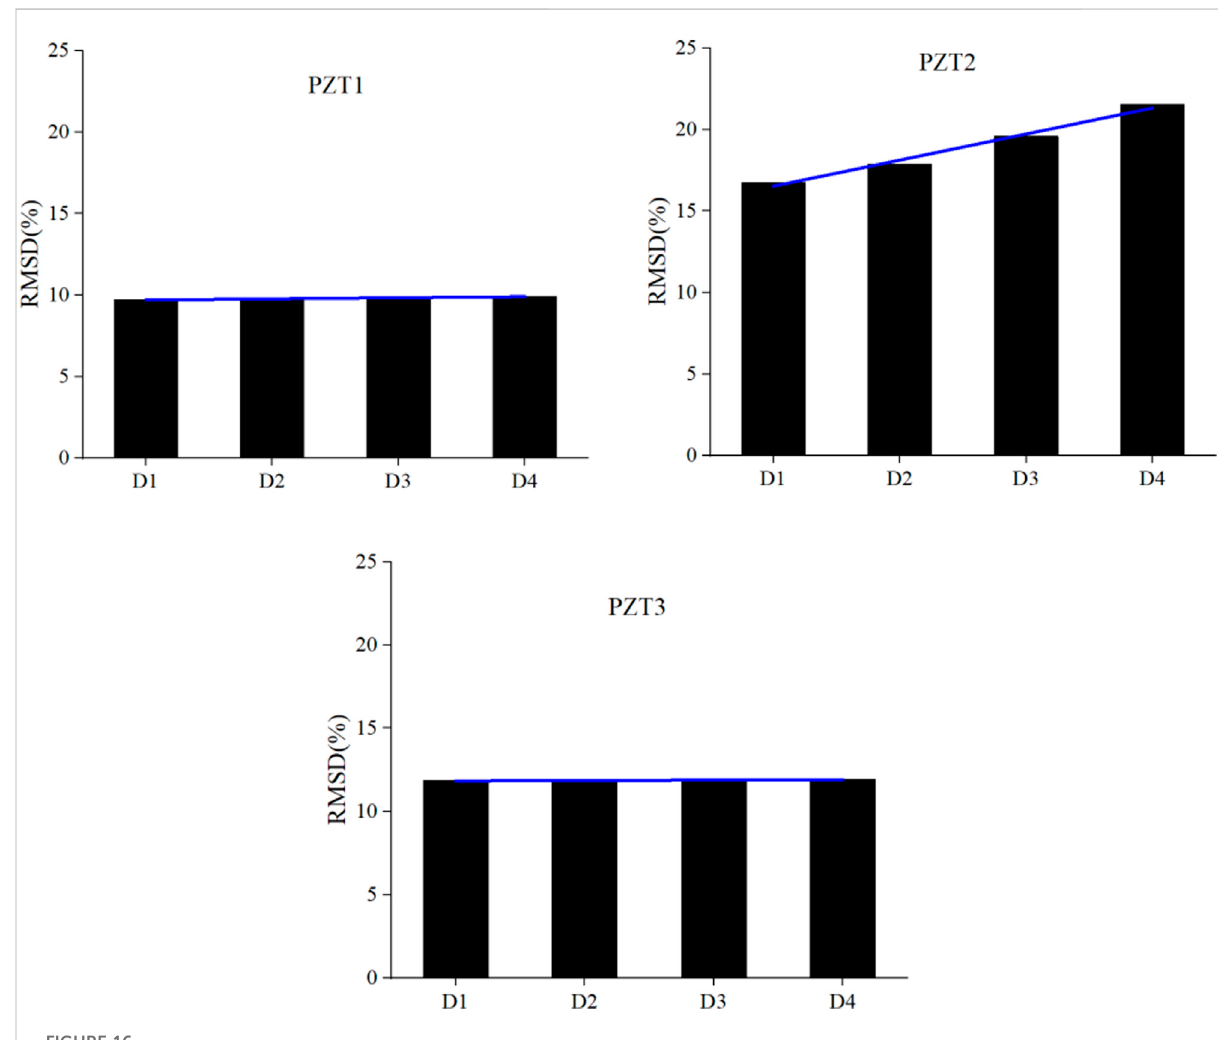
FIGURE 16 RMSD value of each PZT sensor of BE0 using FE